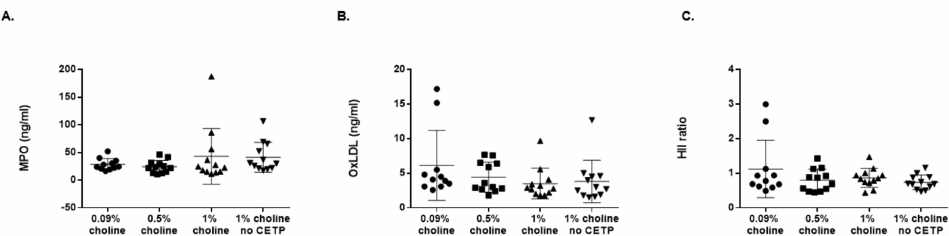
Figure 5. Choline supplementation did not affect plasma-oxidized lipids or HDL antioxidant capacity in vivo. Apoe − / − mice expressing cholesterol ester transfer protein (CETP) or controls (no CETP) were fed chow with supplementation of low, moderate and high choline for 16 wk.